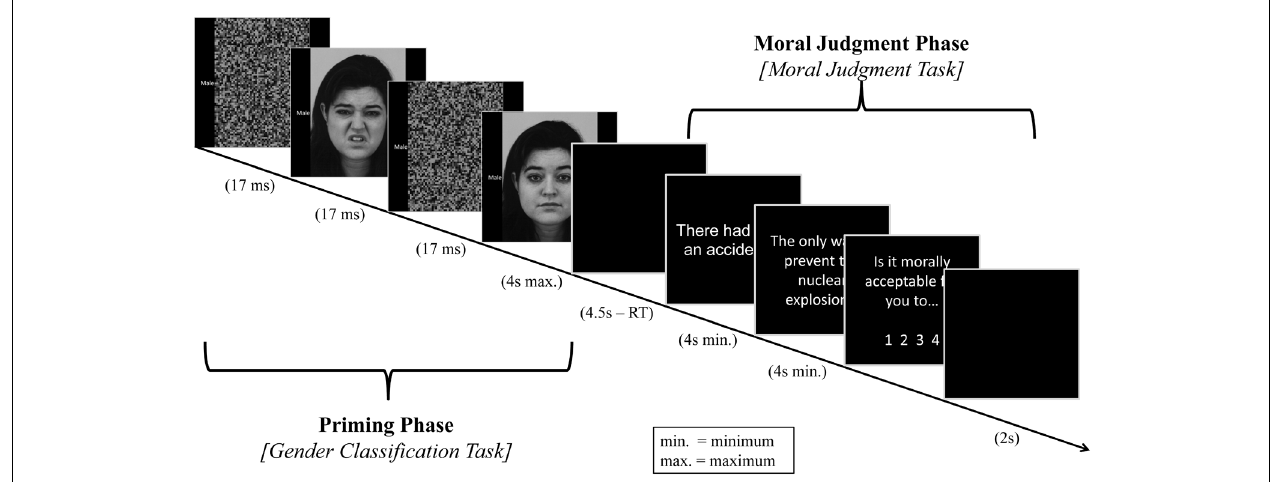
FIGURE 2 | Schematic of one experimental trial (priming phase + moral judgment phase). The face shown here is M31DI from the Karolinska Directed Emotional Faces (KDEF) stimulus set.